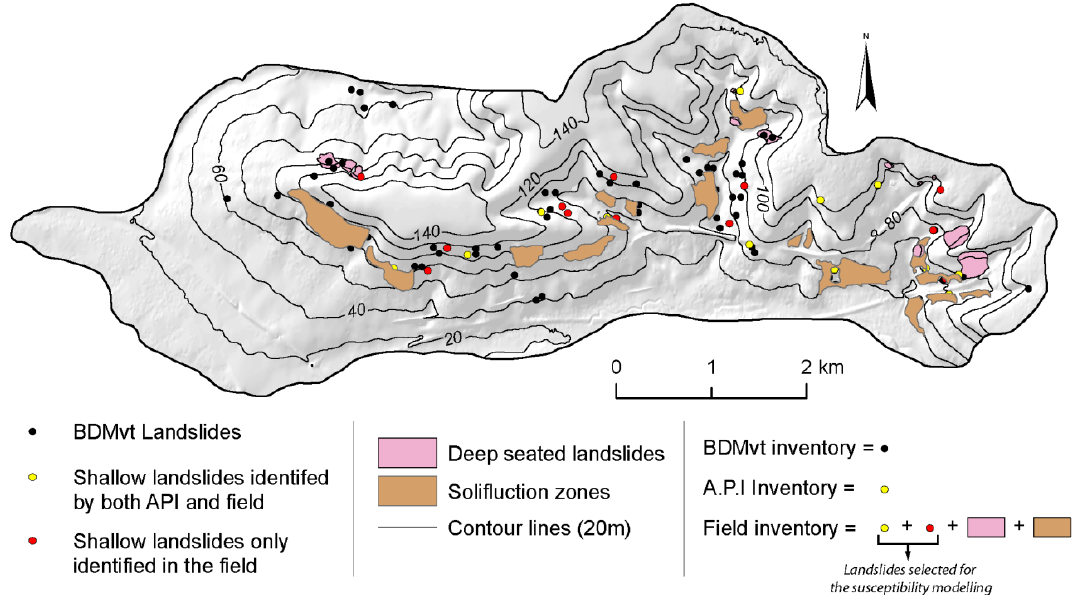
Fig. 4. Landslide inventories of the study area. (Note: all landslides mapped by air photo interpretation were confirmed during the field investigations.)